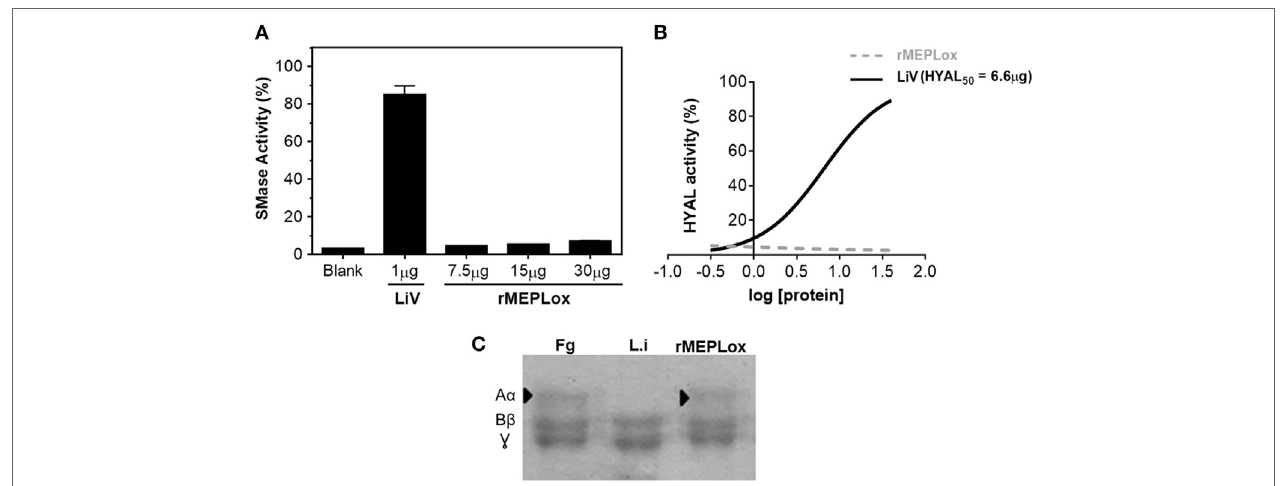
FigUre 6 | Enzymatic activities of rMEPLox. (a) Sphingomyelinase activity assay of rMEPLox at different concentrations (7.5, 15, and 30 µg), using AmplexRed ® Invitrogen Kit. One microgram of Loxosceles intermedia venom (LiV) was used as positive control. (B) Turbidimetric assay for detecting hyaluronidase (HYAL) activity. Serial dilutions of rMEPLox and LiV were used to determine the concentration capable of degrading 50% of the hyaluronic acid in the assay solution (HYAL 50 ). (c) Fibrinogenolytic assay to assess proteolytic activity of rMEPLox. In the first lane, fibrinogen (Fg) showing its three characteristic bands, corresponding to α , β , and γ subunits. The second lane shows Fg previously incubated with LiV, which was capable of completely degrading subunit α . The third lane shows Fg previously incubated with rMEPLox, showing intact Fg